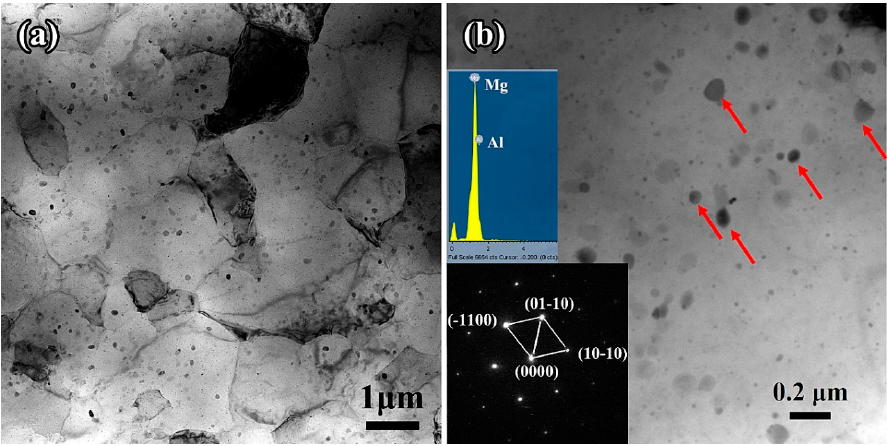
Figure 5. TEM images of extruded ATM610: ( a ) distribution of second phase and ( b ) shape of second phase.